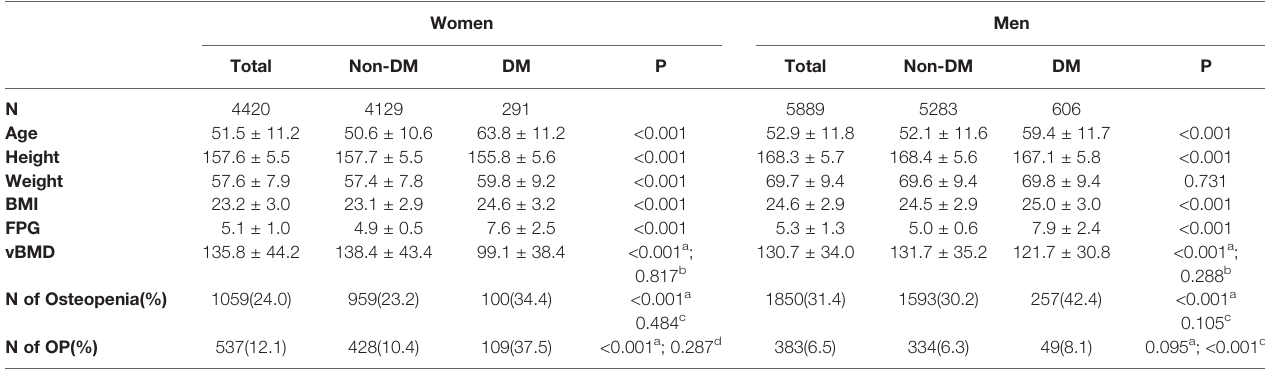
TABLE 1 | Characteristics of participants with and without diabetes mellitus (DM) in the QCT full